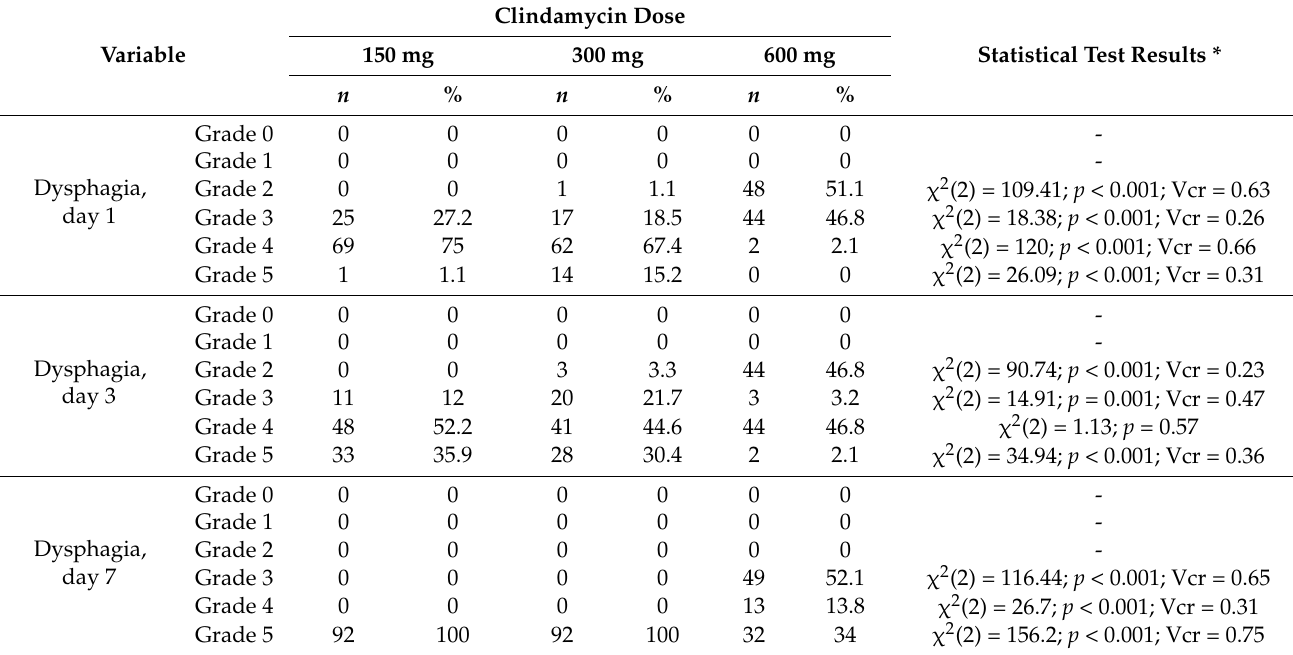
Table 5. Dysphagia in the study groups.